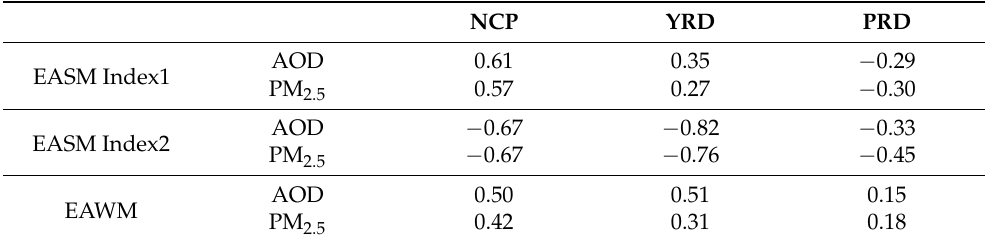
Table 5. Correlation coefficients of East Asia monsoon system with AOD and surface PM 2.5 in NCP, YRD, and PRD in summer and winter between 2006 and